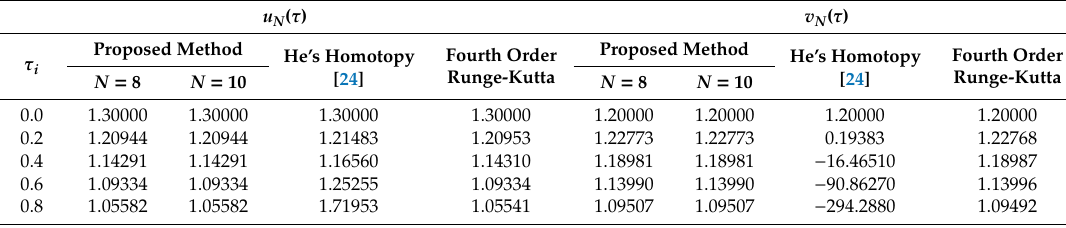
Table 13. Comparing the results for RC collocation method with other